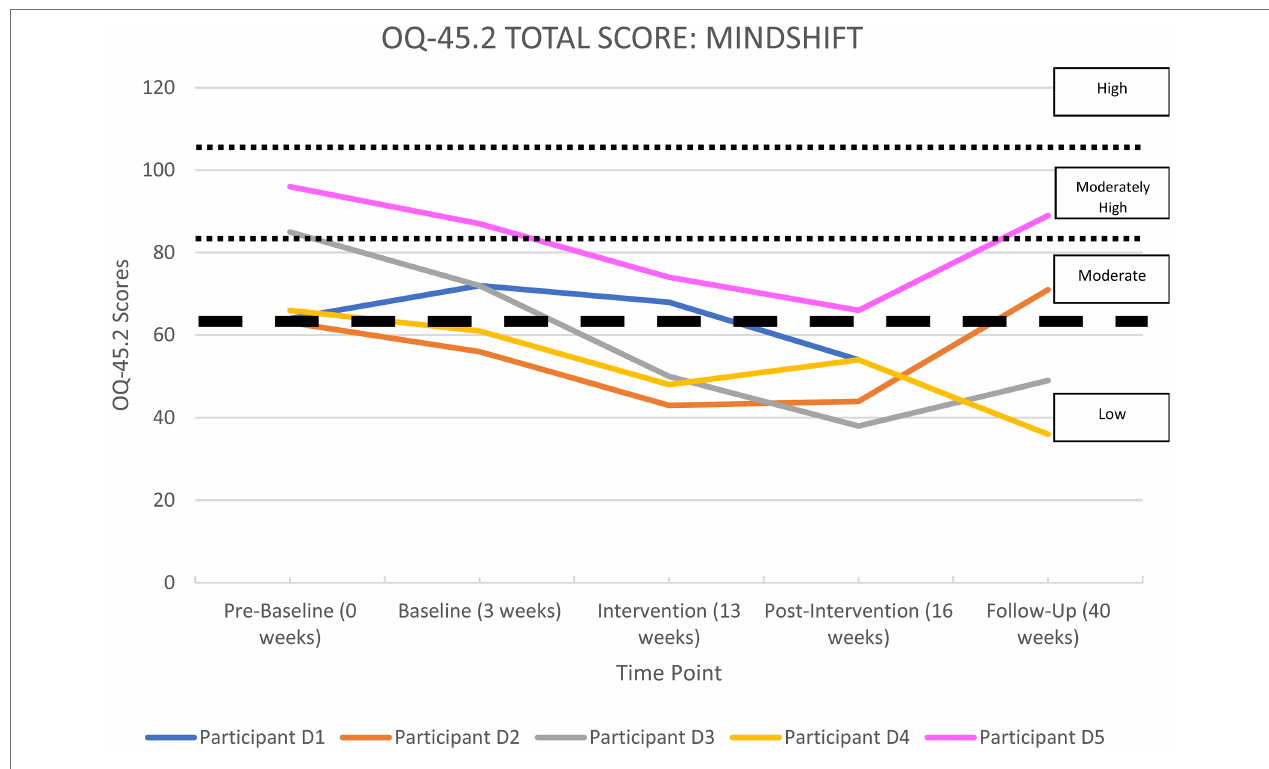
FIGURE 5 | OQ-45.2 total scores for MindShift